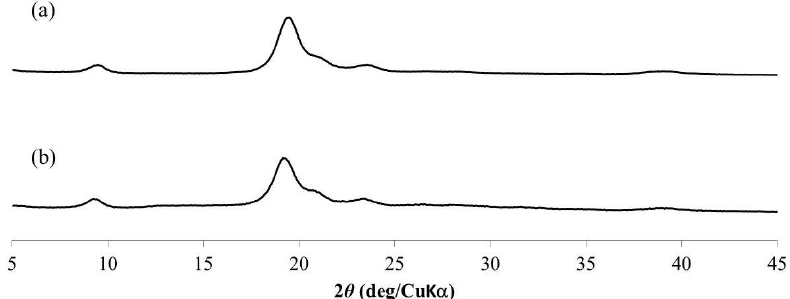
Figure 4. SEM images of CNF film ( a ); CNF- g -PMMA films (MMA; 5 equiv. ( b ); 10 equiv. ( c )); and CNF- g -PHEA film (( d ), HEA; 20 equiv. for an initiating site, conversion; 71%).